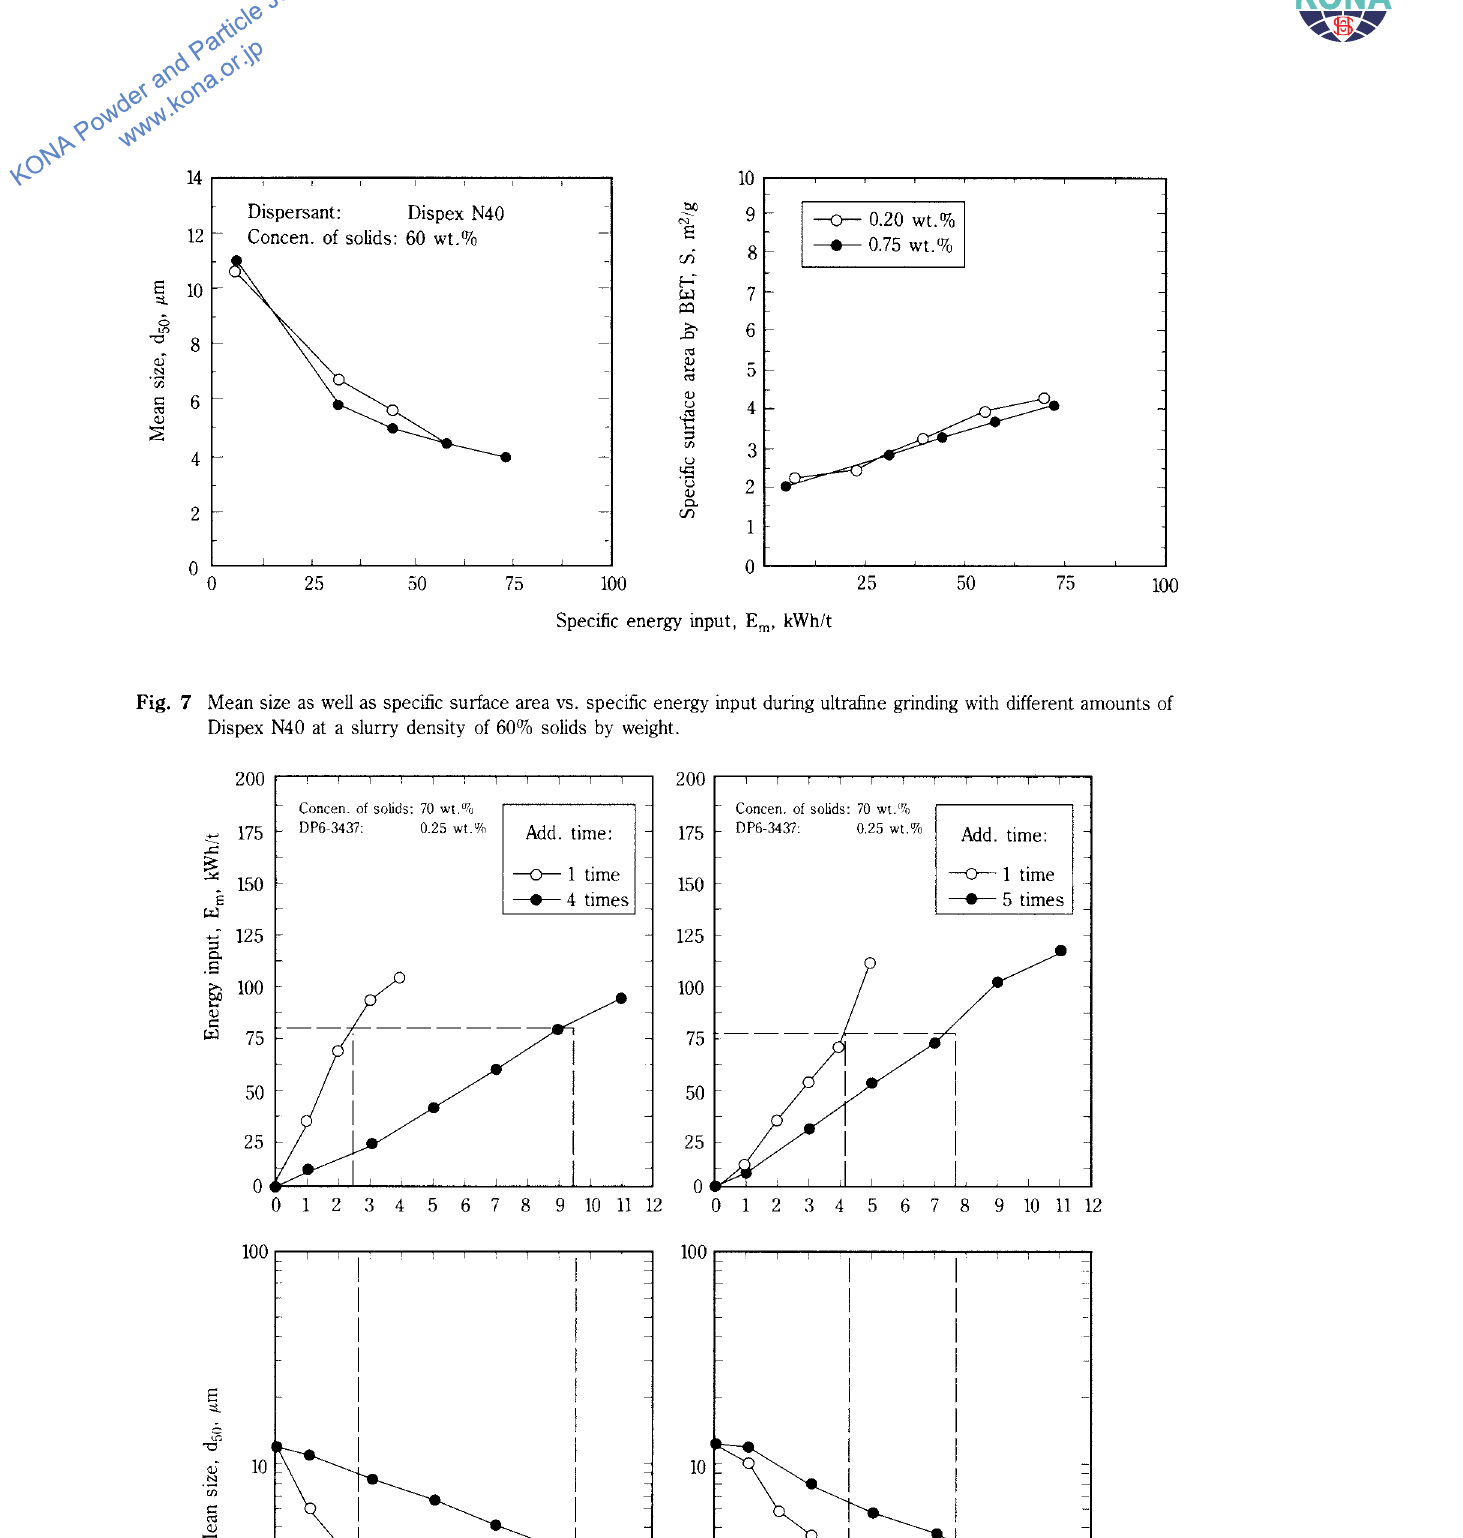
Fig. 8 Energy-size reduction relationships produced by periodic or instantaneous addition of the polymeric dispersants at a slurry concentration of 70 wt. o/o.